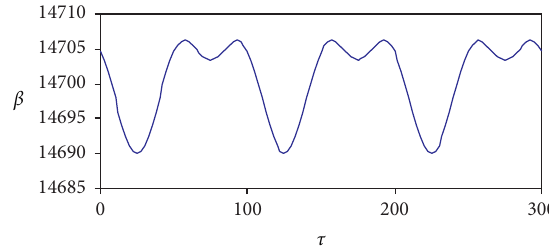
Figure 16: The analytical solution Φ for case (i) in Section 4.2.